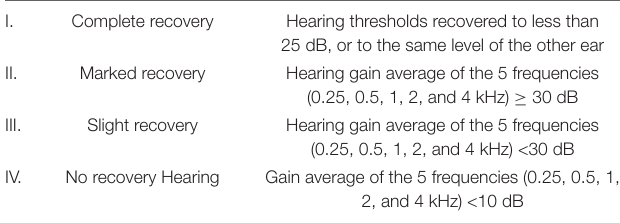
TABLE 1 | Criteria of hearing recovery (according to Kanzaki’ criteria).